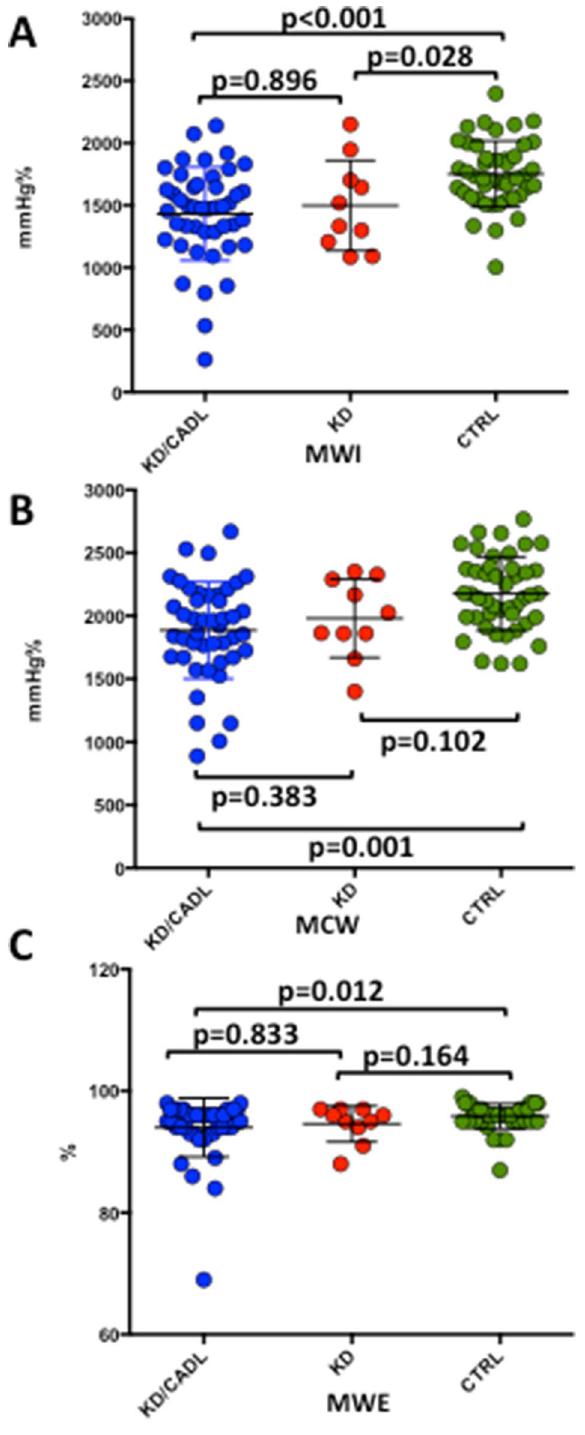
Figure 2. The graphs show global MWI (A) , MCW (B) and MWE (C) significantly reduced in children belonging to the KD/CADL group compared to controls. Likewise, KD group shows lower MWI values compared with CTRL. Graphs in this figure were drawn by using Past software (version 4.02). MWI myocardial work index, MCW myocardial constructive work, MWE myocardial wasted